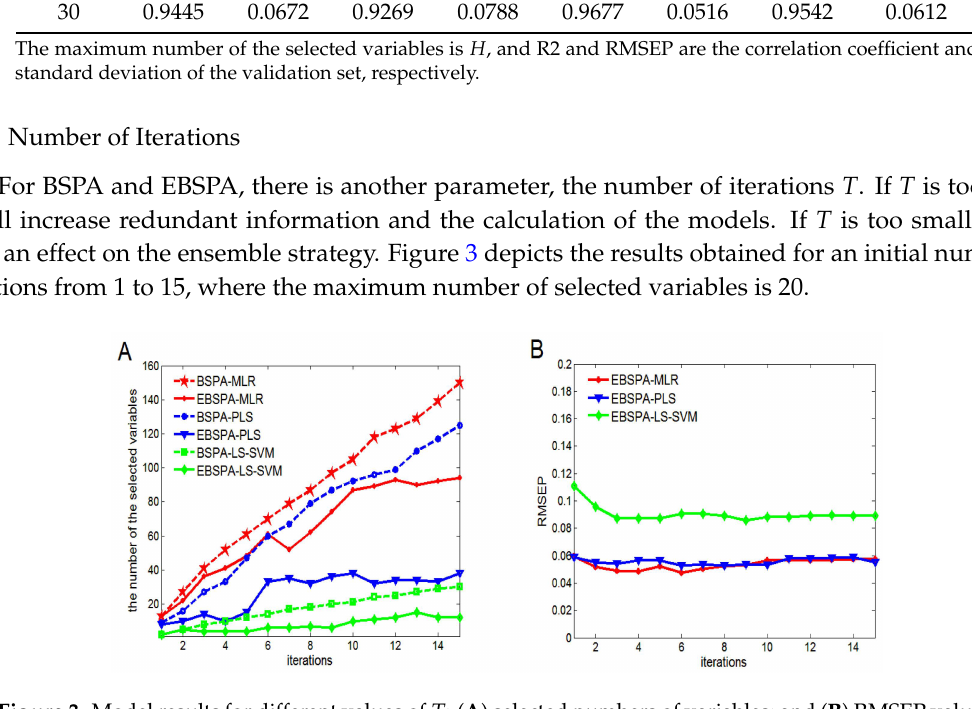
Figure 3. Model results for different values of T : ( A ) selected numbers of variables; and ( B ) RMSEP